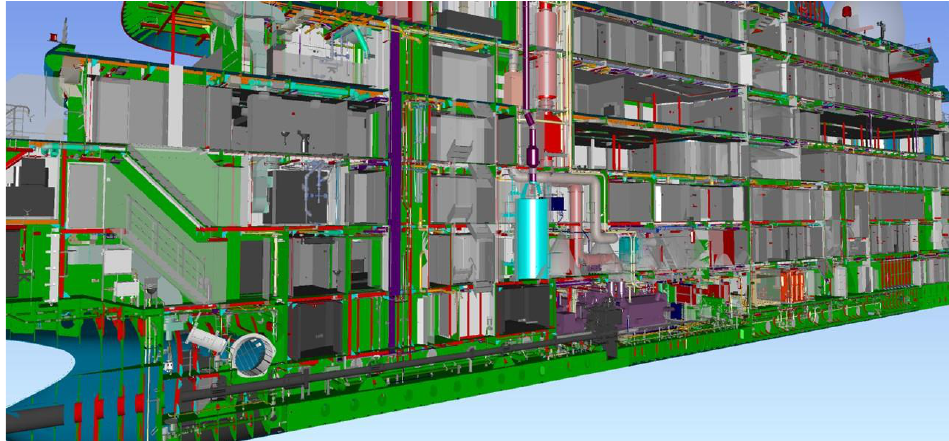
Figure 6. Digital Twin ship prototype.